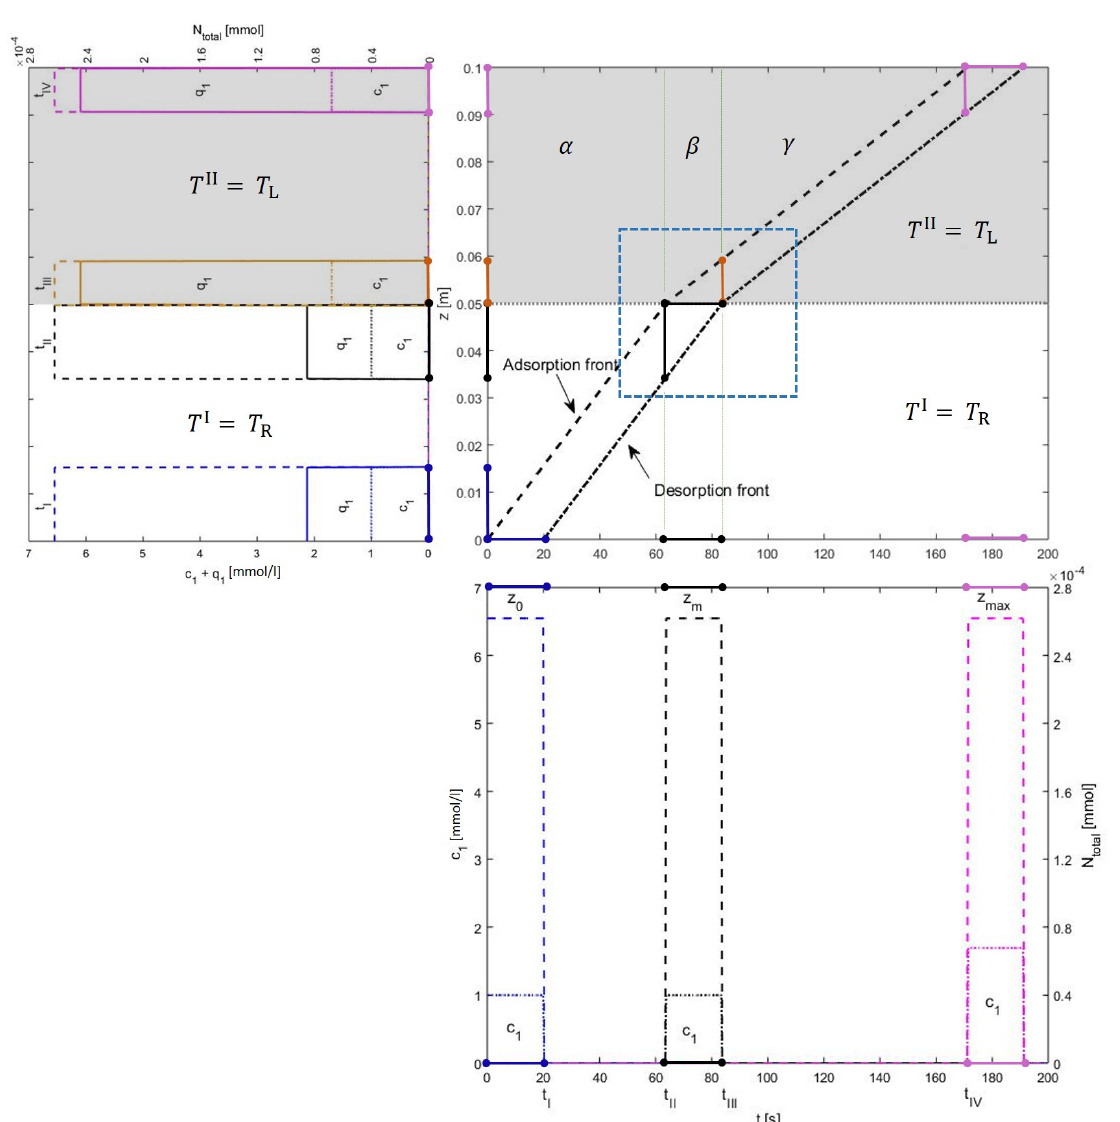
Figure 3. Illustration of the solution behavior in α and γ states for cooling of Type I: Switching is done from reference temperature, T R , to low temperature, T L . Concentrations, associated with left axes, are plotted along the axial coordinate z at particular times inside the column and plotted against the time coordinate t at different locations in the column. The total mass, N total , associated with the right axes of z -plot and t -plot, are also plotted to guarantee the mass balance. The grey area represents segment II that is kept at a low temperature. Every point in the t -plot corresponds to two points in the z -plot and every point in the z -plot corresponds to two points in the t -plot. The blue profile in t -plot is showing the reaching times of the adsorption and desorption fronts to z 0 . Corresponding to it is a blue profile in z -plot at t I = t inj = 20 s . The black profile in t -plot is showing the profile when the fronts reach z m . This crossing is plotted in the z -plot at several positions, that is, black one when the adsorption front reaches z m and orange one when the desorption front reaches z m . The pink profile in the t -plot is plotted at z max . Whereas, the pink profile in the z -plot illustrates the situation when the adsorption front reaches z max . As β is the crucial state, we have marked the area covering this sate and shown it in Figure 4 to delve the transition more